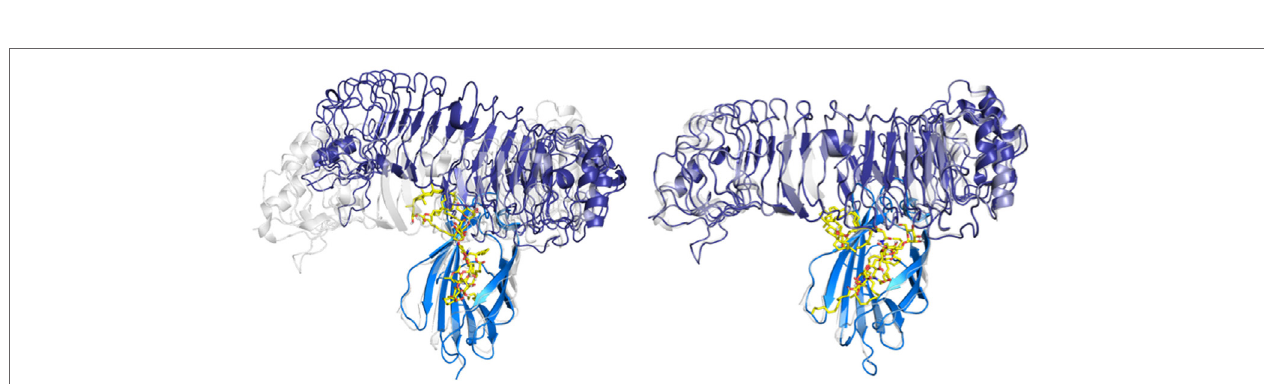
FigUre 7 | Representation of the two poses of HOPA (yellow) docked into myeloid differentiation protein-2/toll-like receptor 4 (blue/violet), Escherichia coli lipid A-like (on the left) and lipid IV A -like (on the right), selected for MD